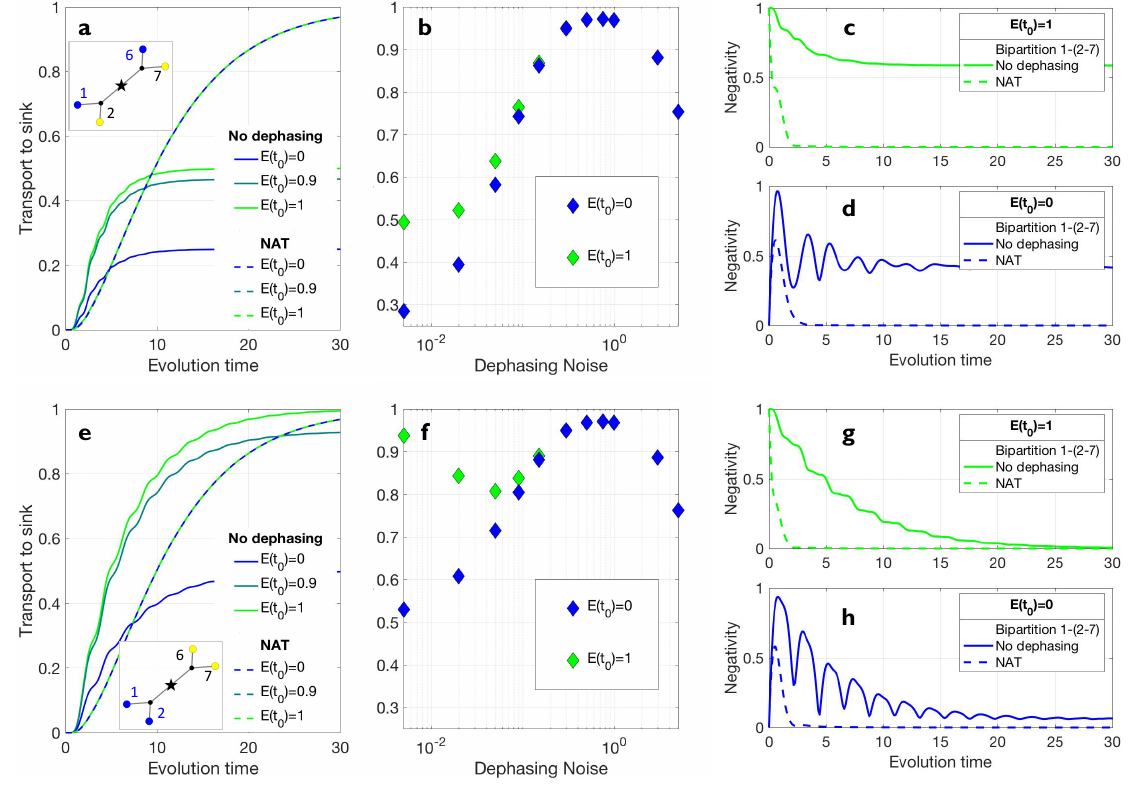
Figure 1. Transport to sink and entanglement evolution for the two initial configurations ( j , k , m , n ) = ( 1,6,2,7 ) (top row of figures) and ( j , k , m , n ) = ( 1,2,6,7 ) (bottom row of figures) of a 7-site network. Colours refer to the different correlation between the excitation and control sites: green for E ( t 0 ) = 1, dark green for E ( t 0 ) = 0.9 and blue for two independent walkers. Solid lines are used for a pure coherent dynamics without dephasing, and dashed lines for the optimal NAT dynamics. ( a , e ) Transport efficiency to the sink as a function of time, with network scheme in the inset. ( b , f ) Transport efficiency at stationary conditions. ( c , d , g , h ) Time-evolution of